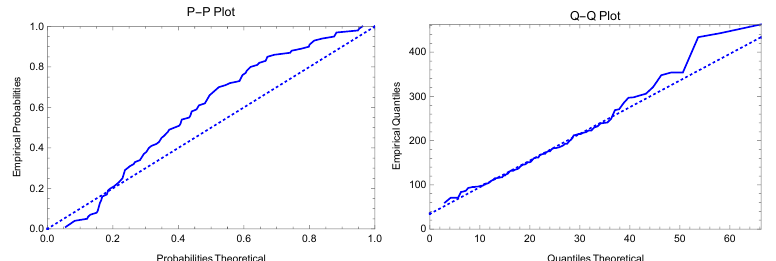
Figure 5. P-P and Q-Q plots of the WGQLD for the rain data.